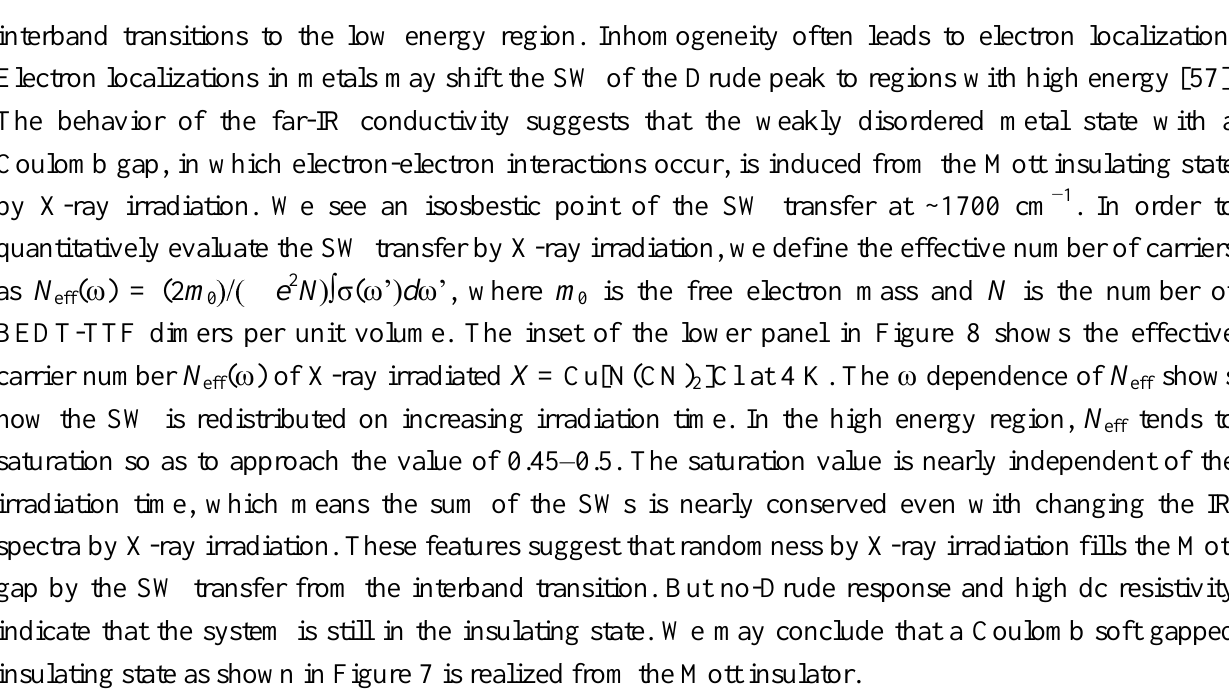
Cu[N(CN) ]Cl 2 2 ]Cl. X-ray is irradiated to the 2